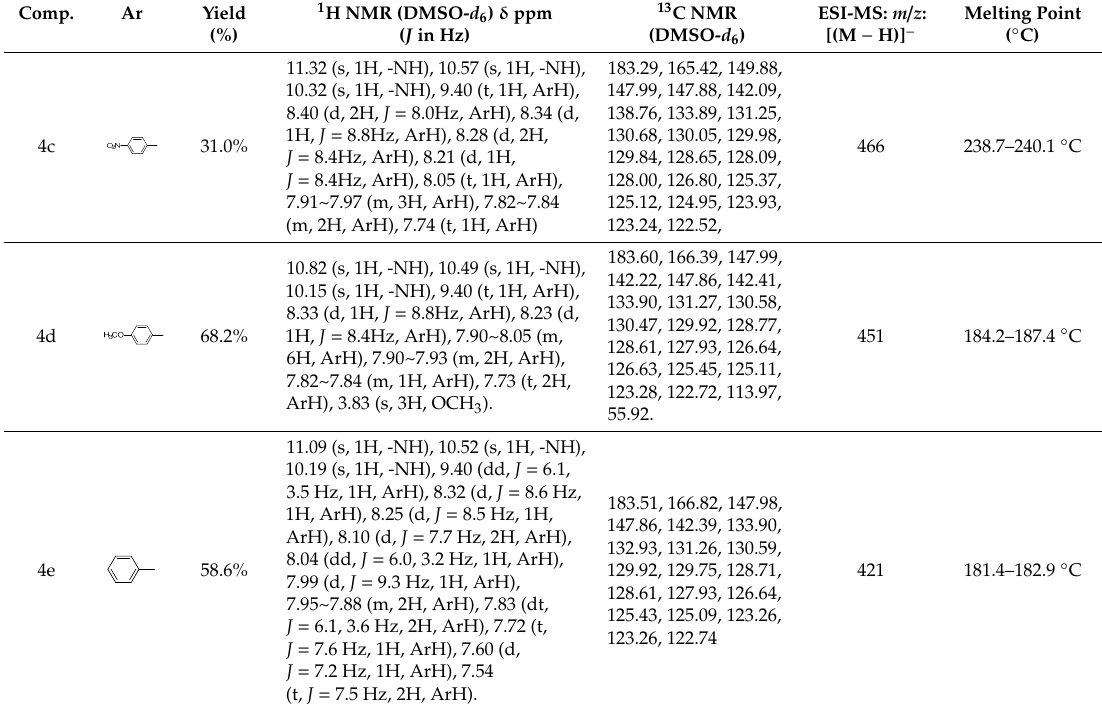
Table 2. Antibacterial activity of 4a–4e presented as the minimum inhibitory concentration (MIC) ( μ M).